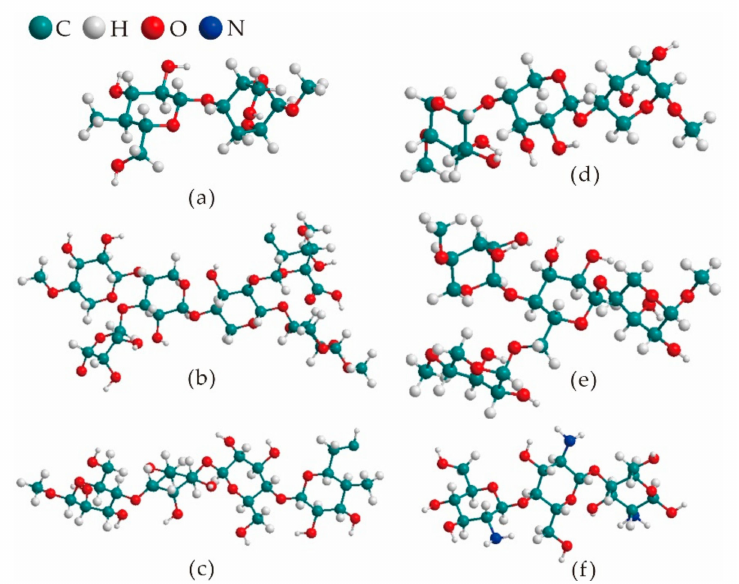
Figure 2. Three-dimensional models of the molecular structure of various polysaccharides. ( a ):Cellulose ( b ): Xylan ( c ): Glucomannan ( d ): Amylose ( e ): Amylopectin ( f ):